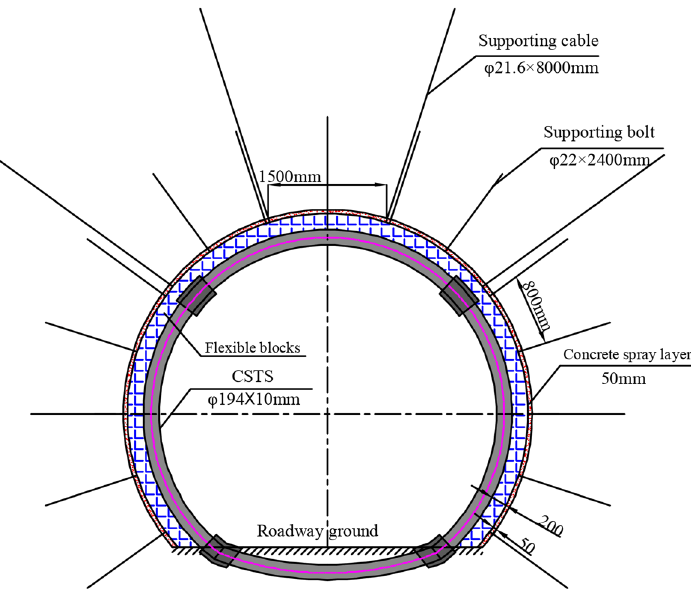
Figure 8. Overall supporting structure in the